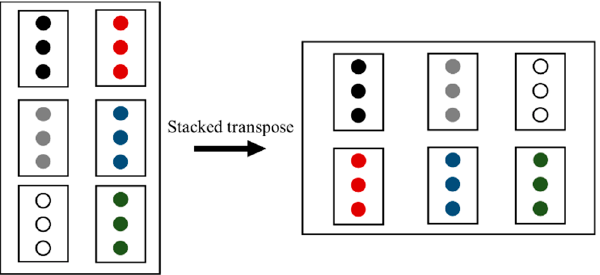
Figure 6. The Schematic diagram of the stacked transpose.